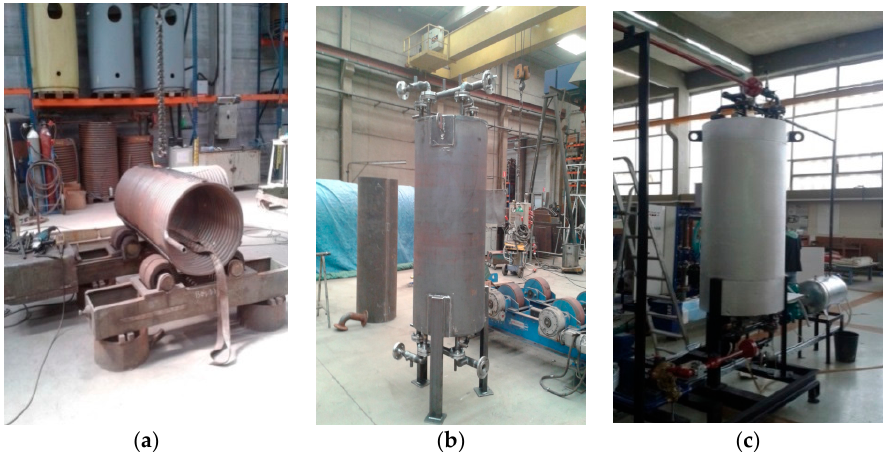
Figure 3. Heat exchanger: ( a ) a helical coil; ( b ) final assembly of the component; and ( c ) insulated and installed component in the installation in the laboratory [3].